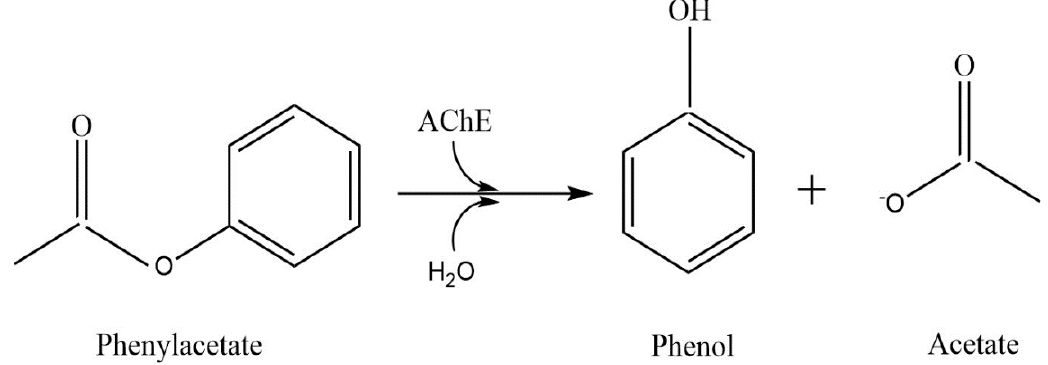
Figure 2. Hydrolysis of phenylacetate with AChE.